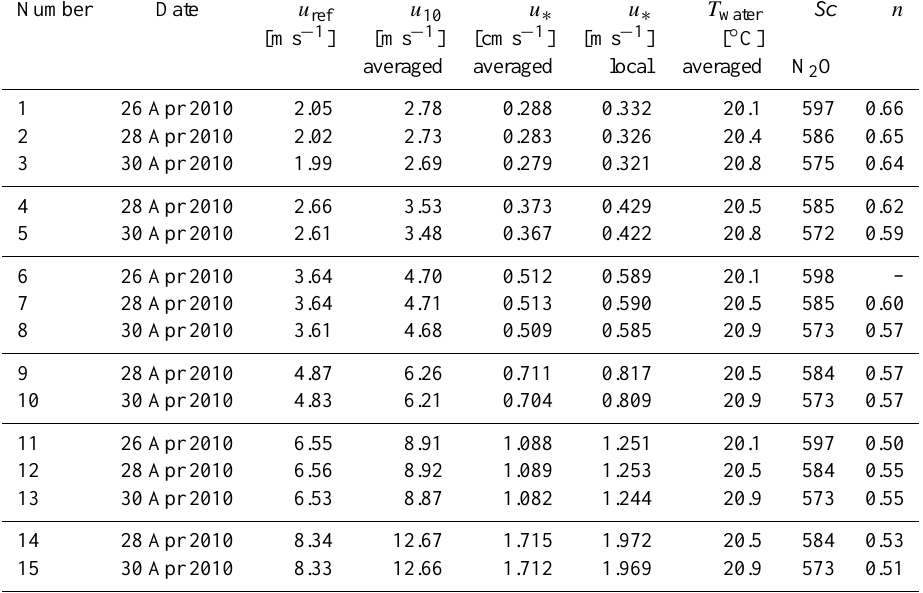
Table A1. Environmental parameters at all measured conditions, including the date, the reference wind speed u ref , the wind speed u 10 , the friction velocity u ∗ , the water temperature T water , the Schmidt number of N 2 O, and the Schmidt number exponent n . The Prandtl number of heat was Pr = 7 . 2 under all measured conditions. The temperature-dependent Schmidt number of N 2 O was taken from Degreif (2006).